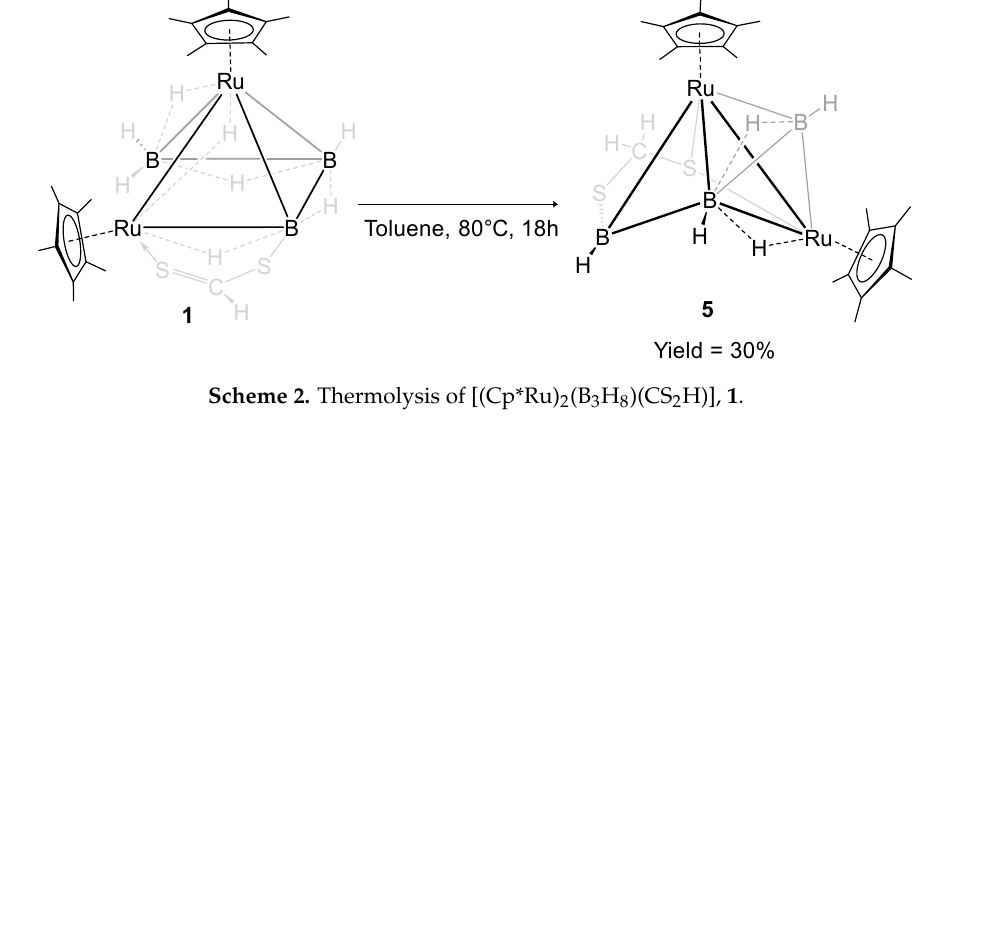
Figure 2 . Molecular structure and labelling diagram of 5 : B1–B2 1.679(11), B1–Ru2 2.098(7),